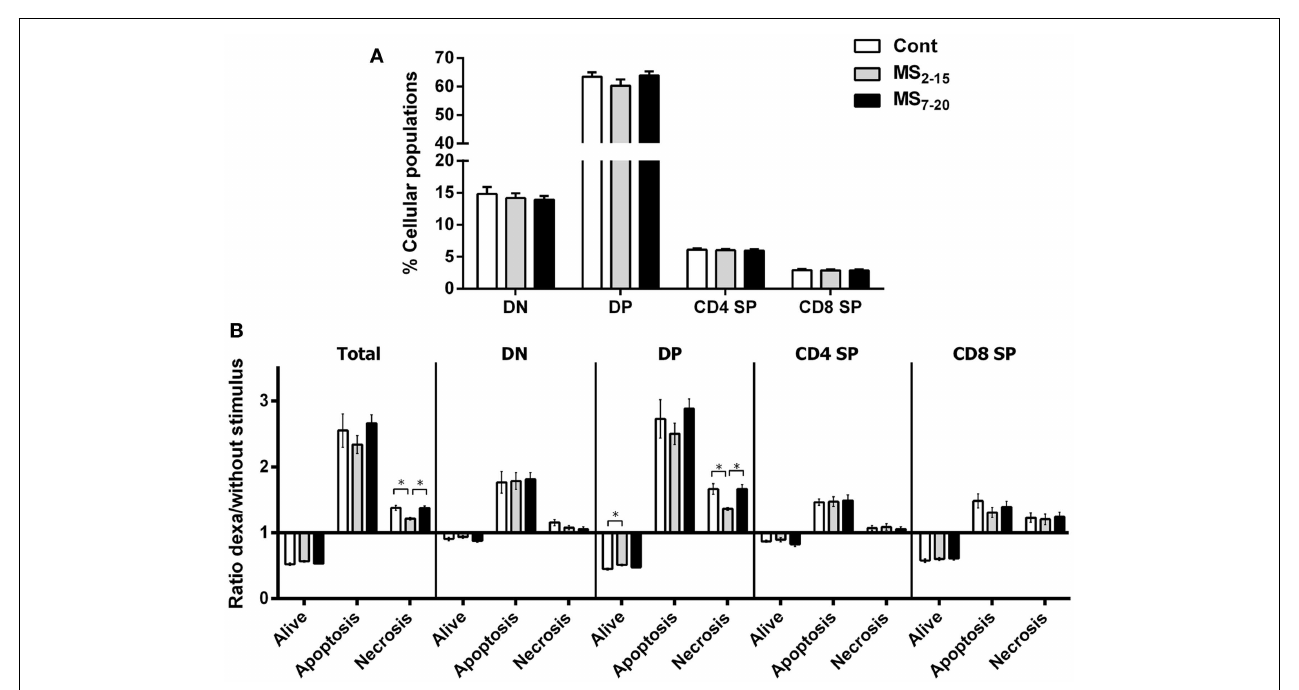
experiments. (B) Thymocytes from Cont, MS 2–15 , and MS 7–20 groups were treated during 4h with dexamethasone followed by specific staining ( Table 2 ) to evaluate apoptosis and necrosis of each cell population by flow cytometry. The data are represented as the ratio between the percentages of dexamethasone treated and untreated cells. Each bar represents the mean + SEM from 11 to 14 rats per group.